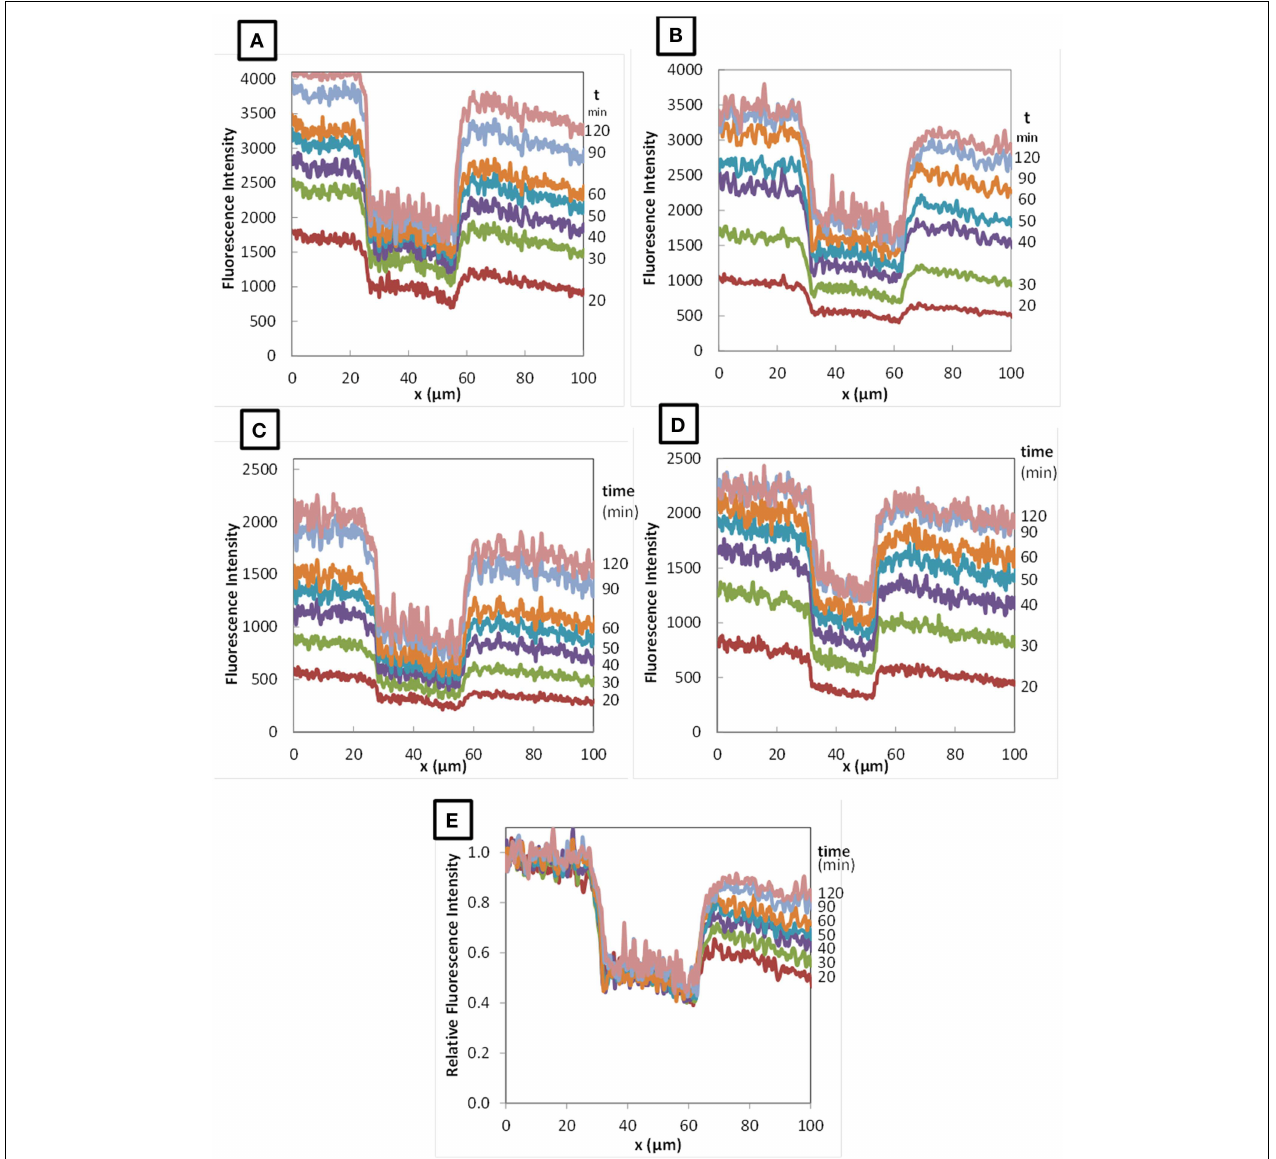
TIL1230 (D) as function of diffusion time (from 20 to 120min). (E) Typical relative fluorescence intensity profile obtained with RITC-dextran 70kDa in